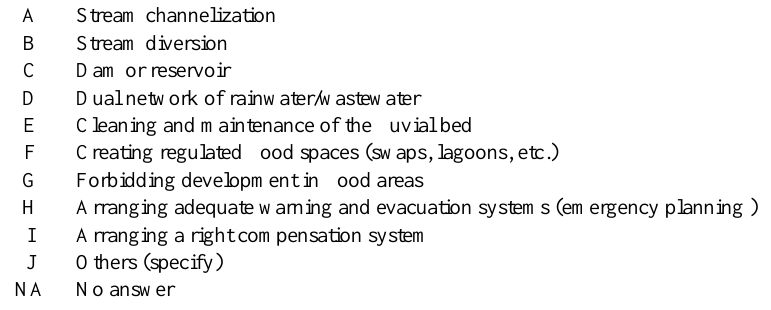
Table 2. Range of different flood management options. Residents (respect to Figs. 7 until 11).